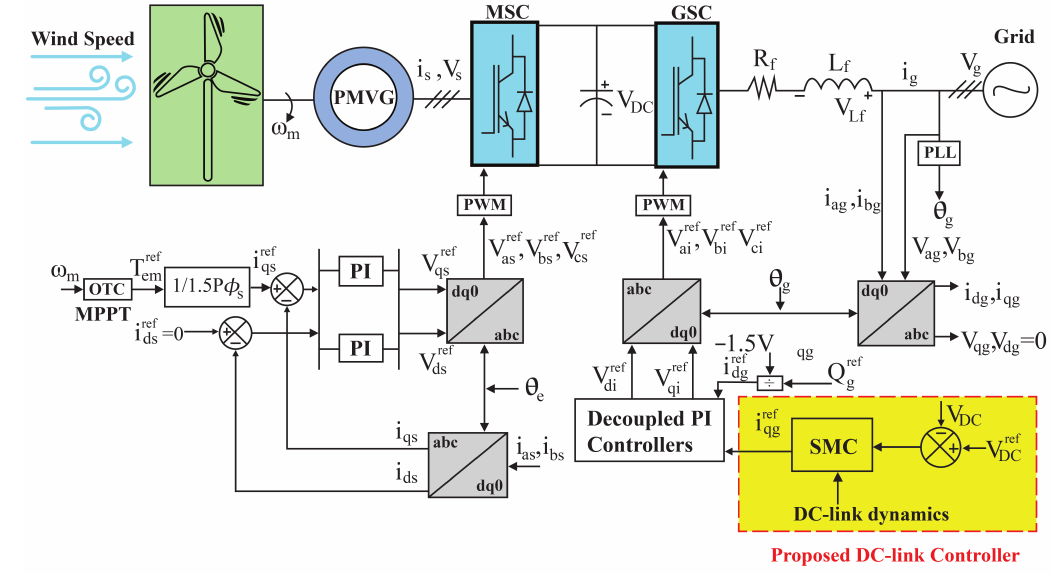
Figure 2. Overall control structure of PMVG-based WECS with proposed DC-link